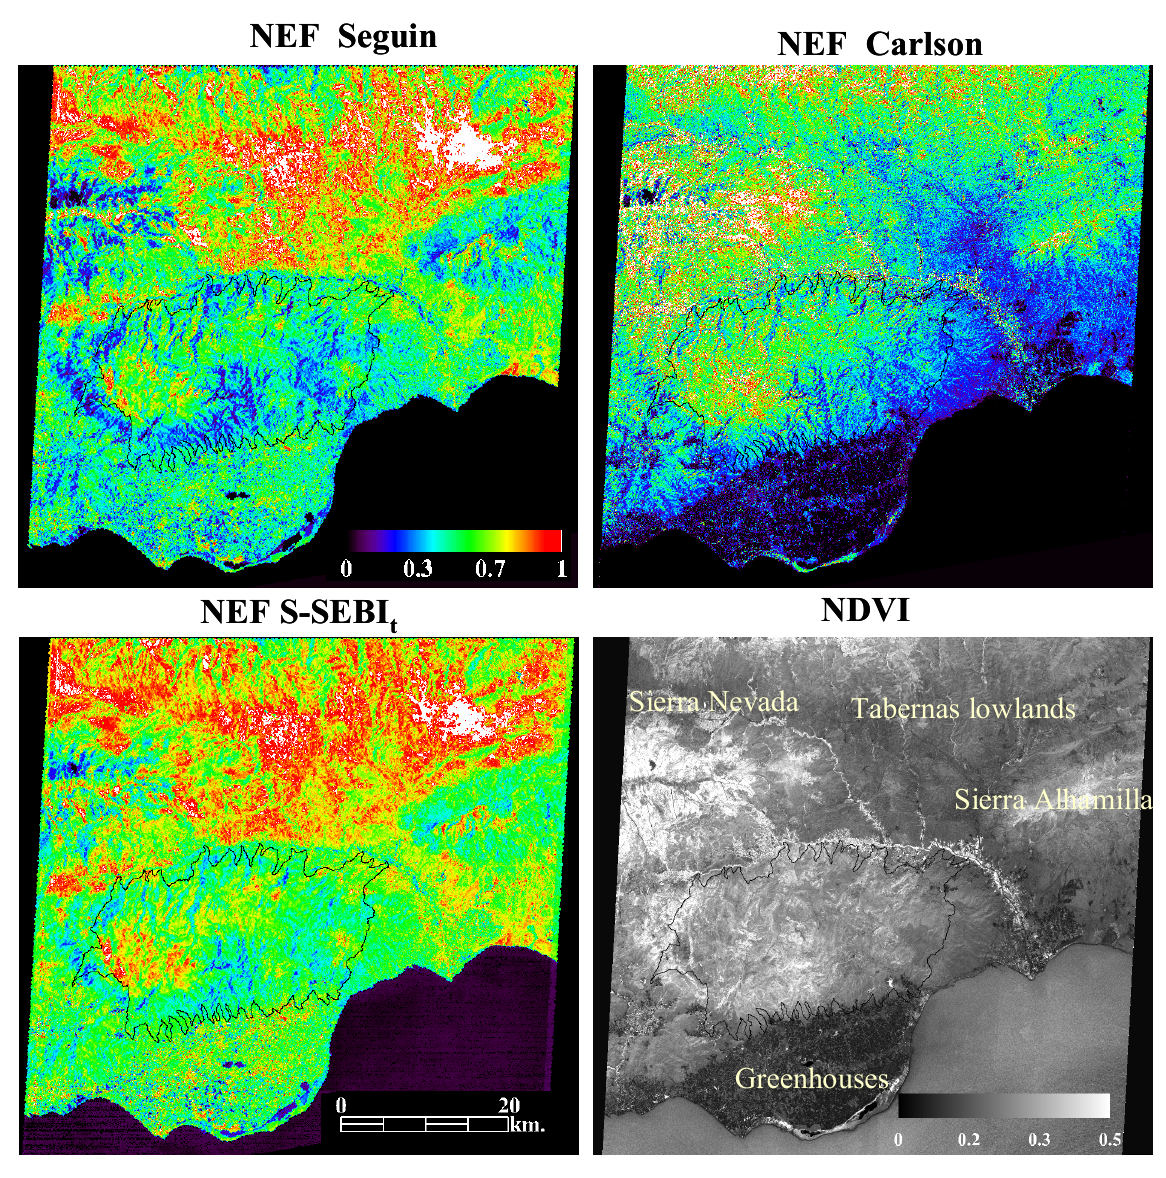
Figure 3. NEF (non-evaporative fraction) using NEF , NEF and NEFS- models for July Seguin Carlson, SEBIt. 18, 2004. NDVI levels on this date are shown in the grey scale image. The Sierra de Gádor in the center of the study site is outlined in black. Linear regression of NEF on the three dates using all the pixels in each scene, including sea water, and the greenhouse area, shows (Table 1) very good correspondence between NEF and NEF Seguin S-SEBIt. but not between NEF and the other two Carlson